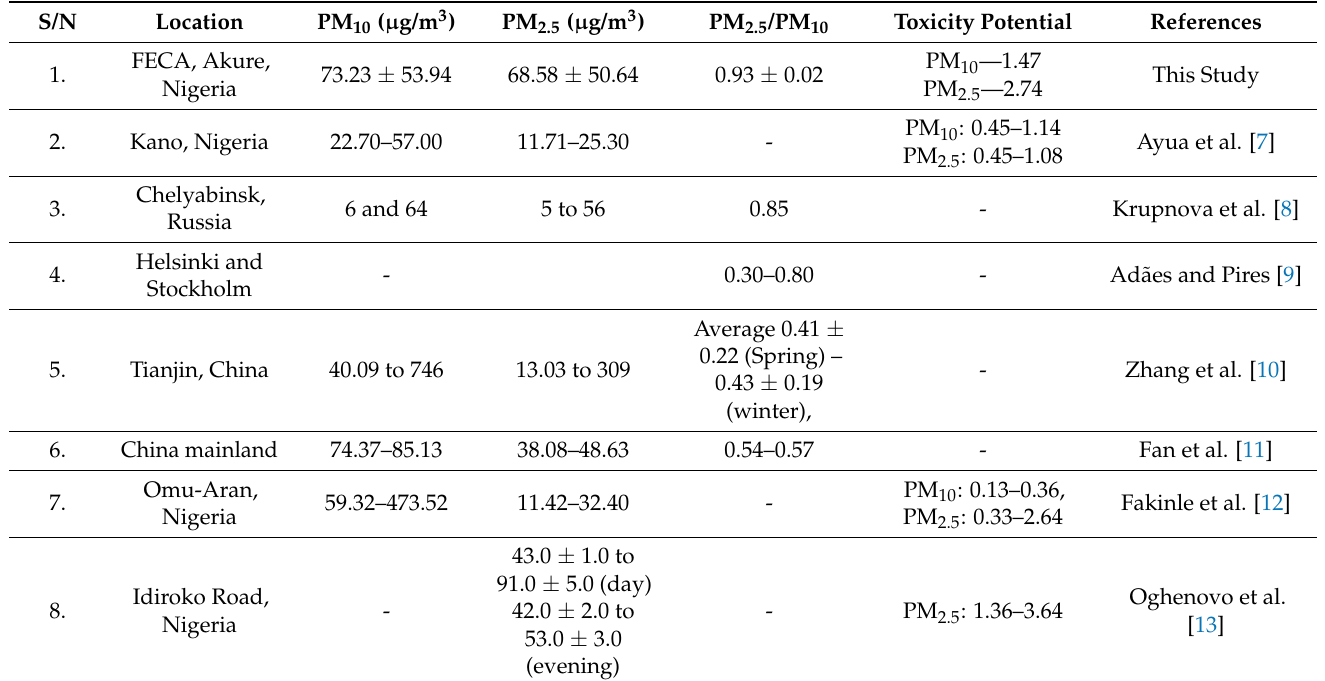
Table 1. Comparison of the results of our study with previous ones in Nigeria and Other